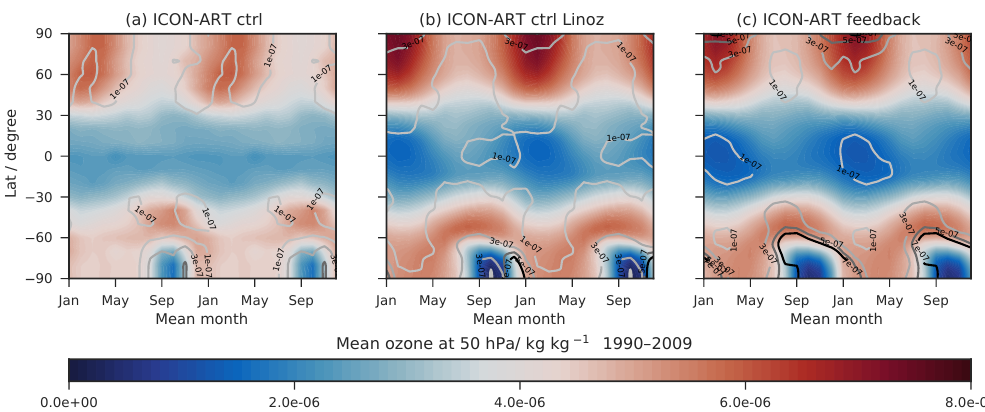
Figure 7. Monthly averaged zonal means of ozone (kgkg − 1 ) at 50hPa (shown twice) for the period from 1990 to 2009 (shaded). Contour lines represent the standard deviation of the monthly means. (a) Ozone climatology as used in the control simulation; (b) non-interactive Linoz ozone; (c) interactive Linoz ozone.